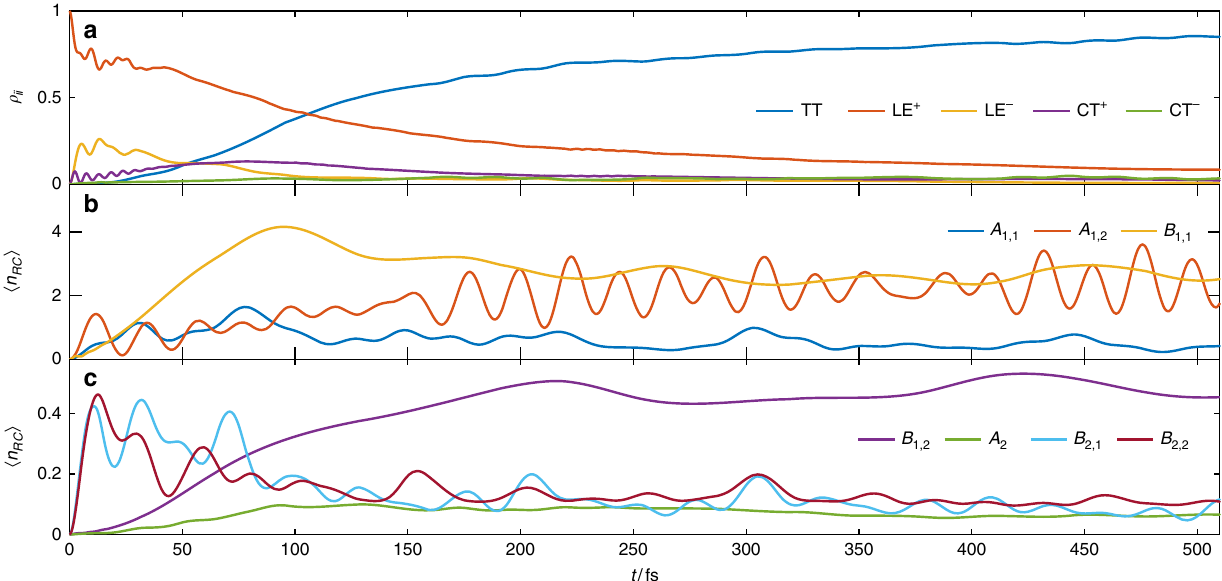
Fig. 4 Simulated SF dynamics in DP-Mes. Electronic populations ( a ) and environmental RC occupation dynamics ( b , c ). For <20 fs, damped Rabi oscillations transfer the population from LE + to LE − and CT + . At subsequent times TT mirrors the LE + decay leading to SF on a time scale of 200 fs and suggesting a direct SF pathway. Similar time scales are present in the bath excitation n RC of B 1 and B 2 . The fi nal TT yield reaches 90% after 1 ps